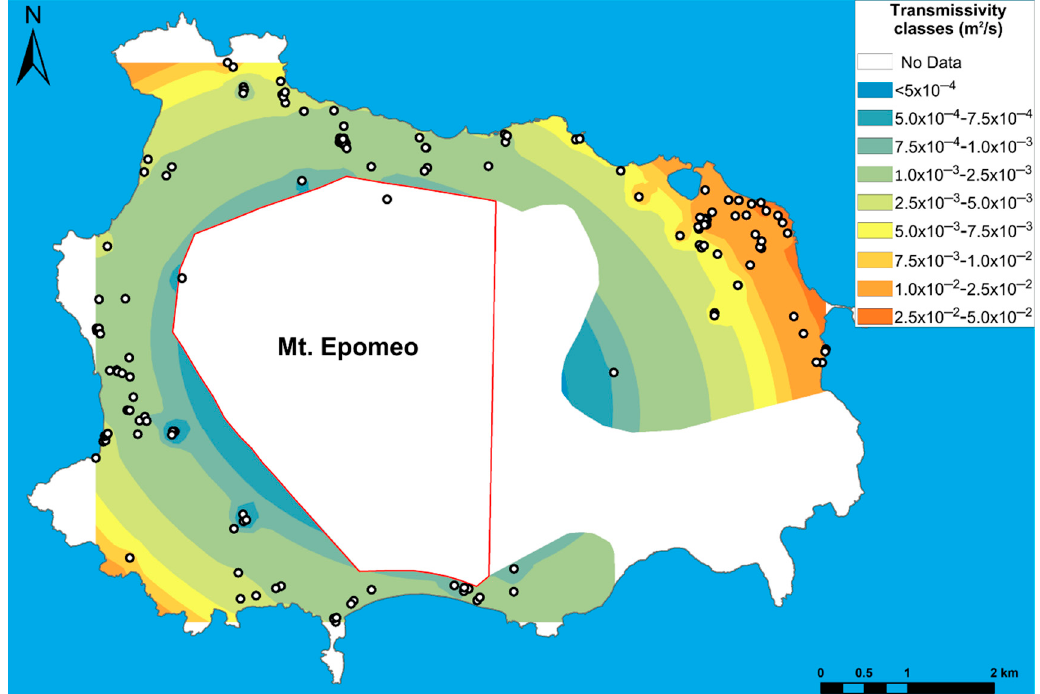
Figure 7. Map of transmissivity estimated with Disjunctive Kriging.